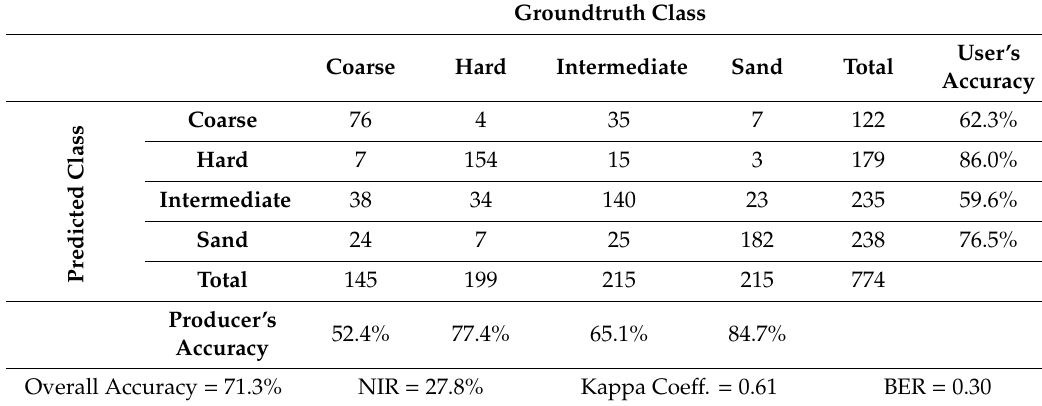
Table 9. Confusion matrix for Random Forest classification of 2012 data. (BER: balanced error rate; NIR: no information rate; values in the body of the table indicate number of validation groundtruth points).